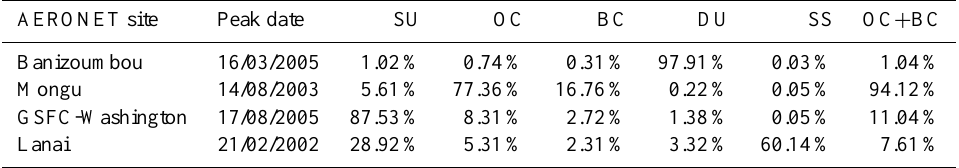
Table 1. Data set derived from GOCART global chemical data comprising the four dominant aerosol type cases studied in this work. Note that SS at Lanai is the least “dominant” aerosol type case, with marine aerosol being mixed with other aerosols in the proportion ≈ 60% :